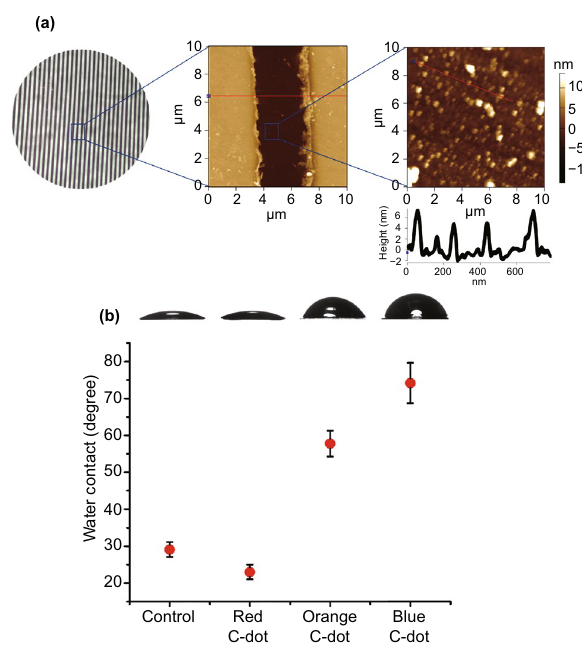
Fig. 1 Characterization of the carbon‑dot‑IDE sensors. a Optical image of the IDE (left) and atomic force microscopy (AFM) images showing ubiquitous C‑dots deposited upon the IDE surface between the gold fingers. b Water contact angles (WCA) recorded for the three C‑dot‑IDEs. The control sample corresponds to an IDE without deposited C‑dots. (Color figure